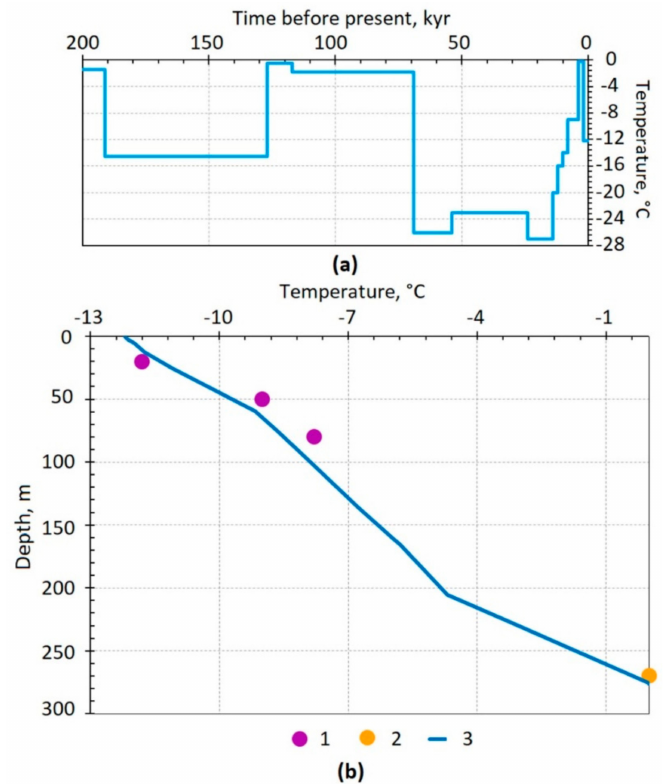
Figure7. Testingthescenarioofthegeologicaldevelopmentbasedonthegeocryologicaldataofborehole c-B: ( a ) paleotemperature scenario; ( b ) results of test modeling at the heat flux of 60 mW / m 2 : 1—ground temperature according to the geothermal observations in borehole c-B; 2—temperature obtained by extrapolating data for the borehole with due account for the geothermal gradient; 3—estimated temperature